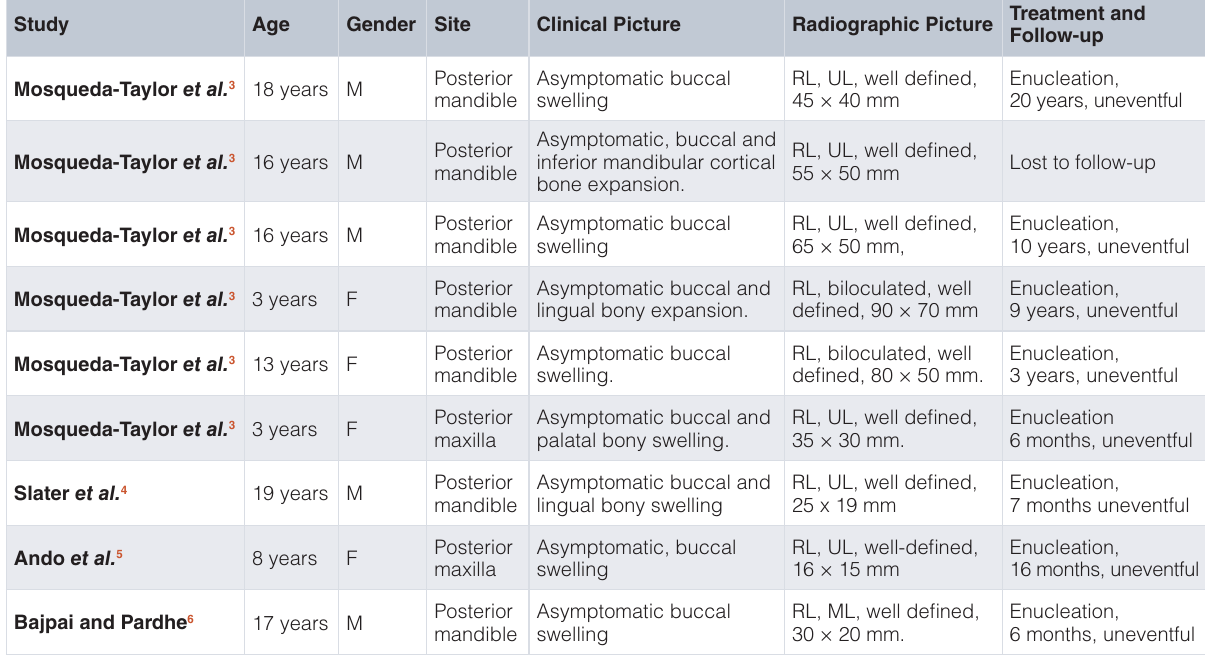
Table 1. Clinicopathological and radiographic data of the nine documented cases of primordial odontogenic tumor. M: Male; F: Female; RL: Radiolucent; UL: Unilocular; ML: Multilocular; mm: